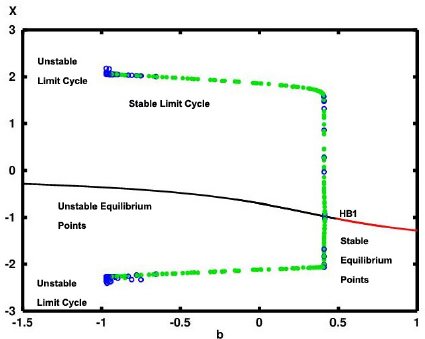
Figure 42. One-parameter bifurcation of recovery variable concerning parameter b with parameters a = 0.8 , b = 0.7 & c = 3 . Stable (green filled circles) and unstable (blue vacant circles) branches of periodic solution of the BVP model showing di ff erent dynamical